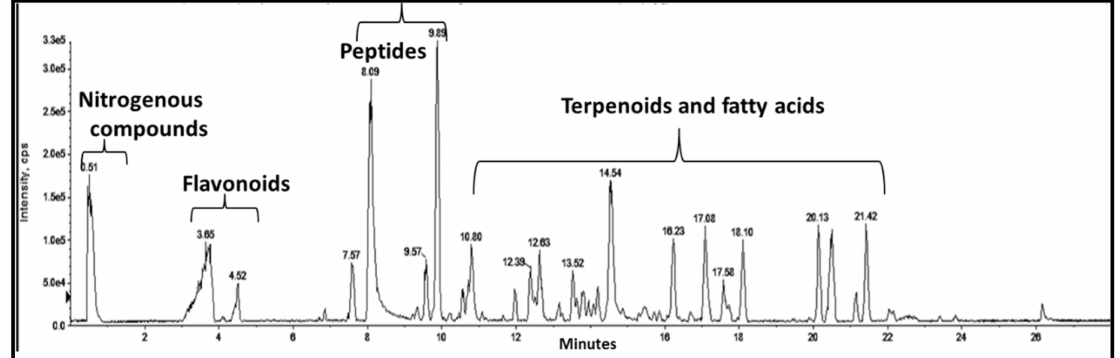
Figure 5. Base peak chromatogram of the UPLC/MS analysis of J. integerrima leaves